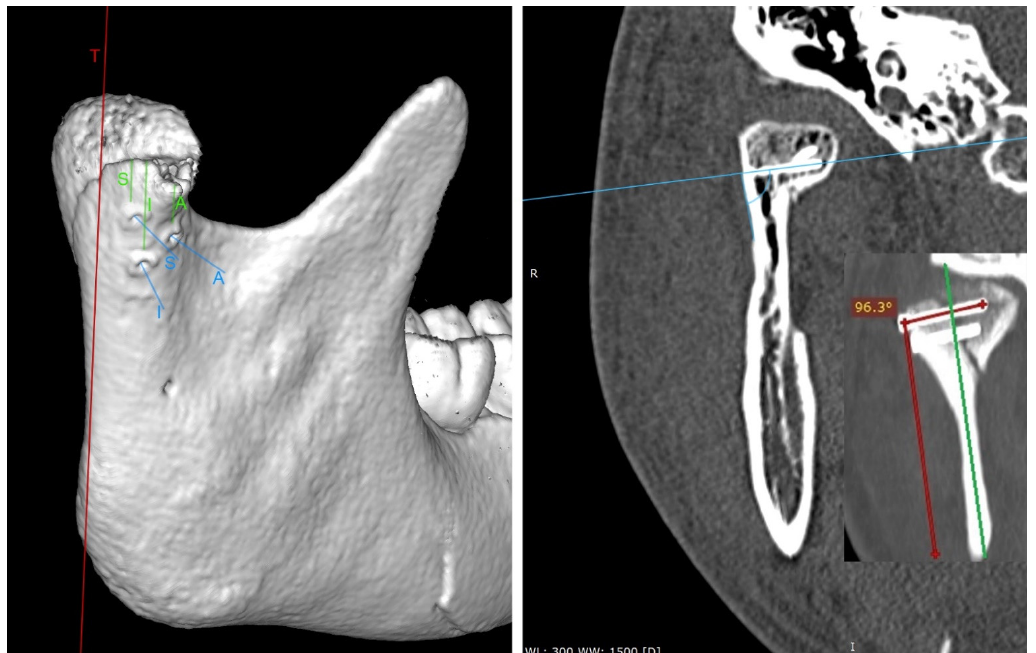
Figure 4. Postoperative radiological examination. On the left, computed tomography acquired immediately after the surgery (view 3 / 4 laterally). This 3D imaging reconstruction shows the screw location used in the study. T—tangent line in the lateral view to the posterior edge of the mandible. The measurements of the distance between the screws and the fracture line are marked in green. The screw insertion directions are shown in blue. S—superior screw; I—inferior screw; A—anterior screw. On the right, a coronary cross-section (taken 12 months after the end of treatment) set on sample screws and measures their angle of insertion into the